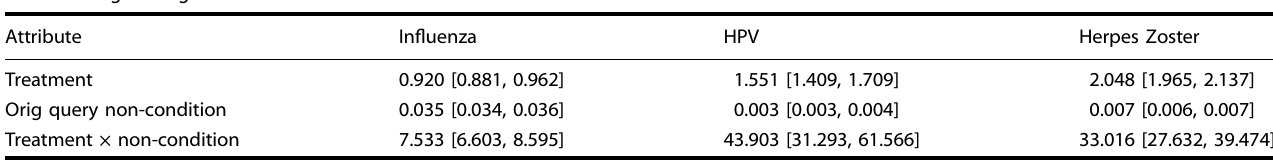
Table 4. Logistic regression model of future vaccine